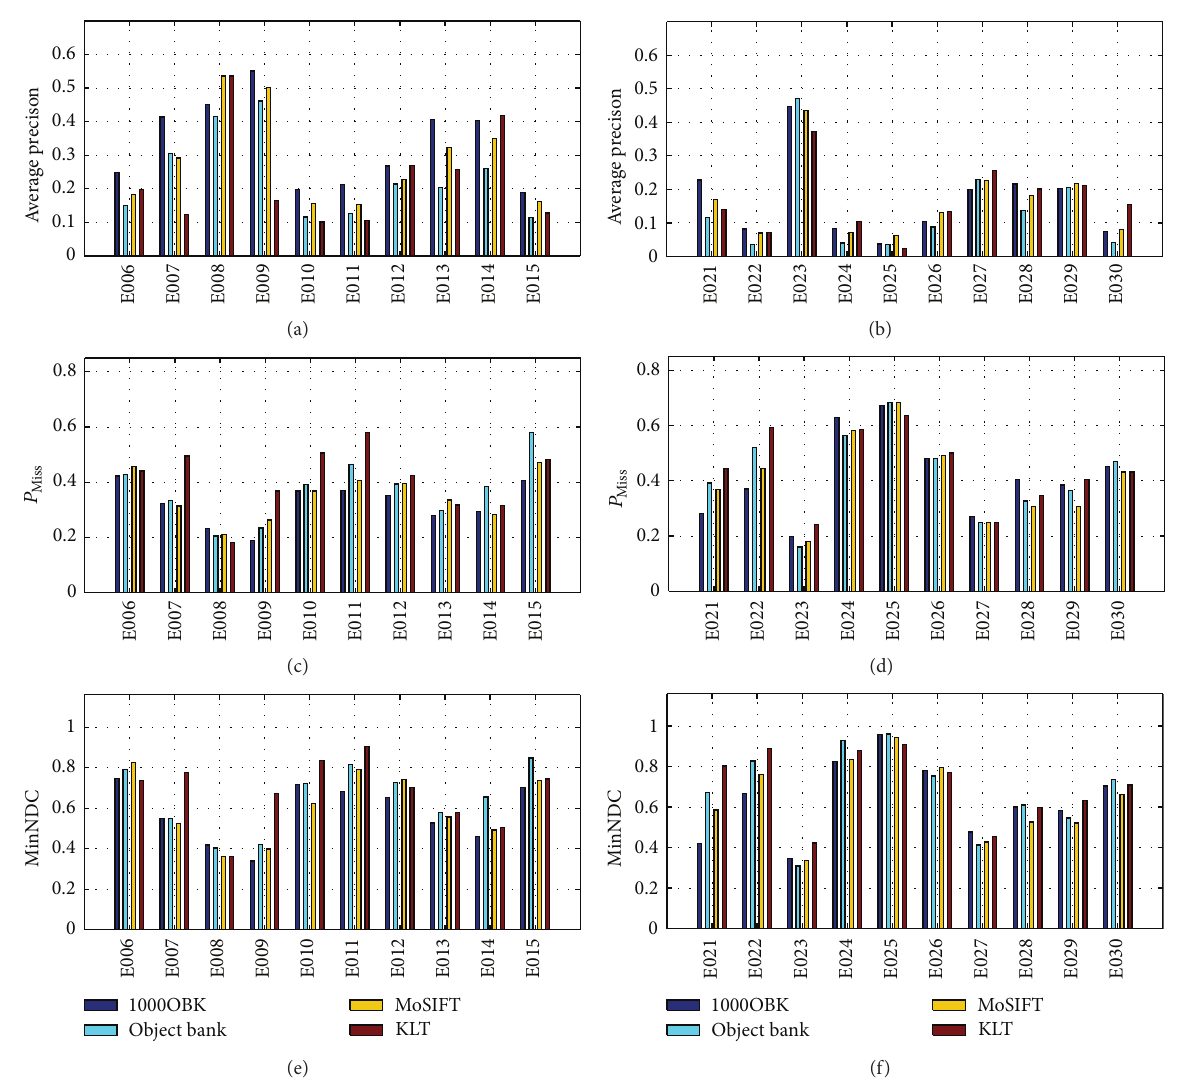
Figure 6: Comparison of MED performance among 1000OBK, object bank, MoSIFT, and KLT on the 20 events of TRECVID MED 2012 , and (e–f) for dataset, with (a–b) for AP, (c–d) for 𝑃 Miss